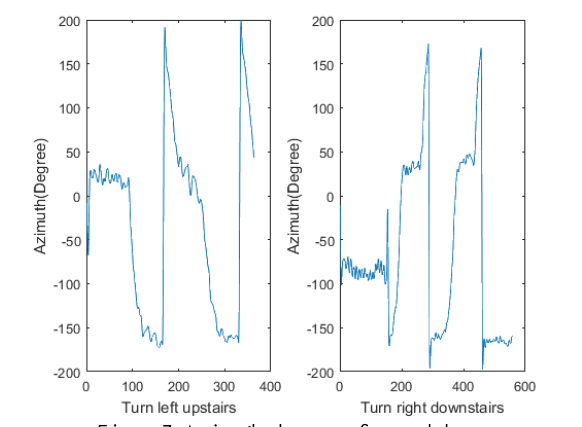
Figure 7. Azimuth changes of up and